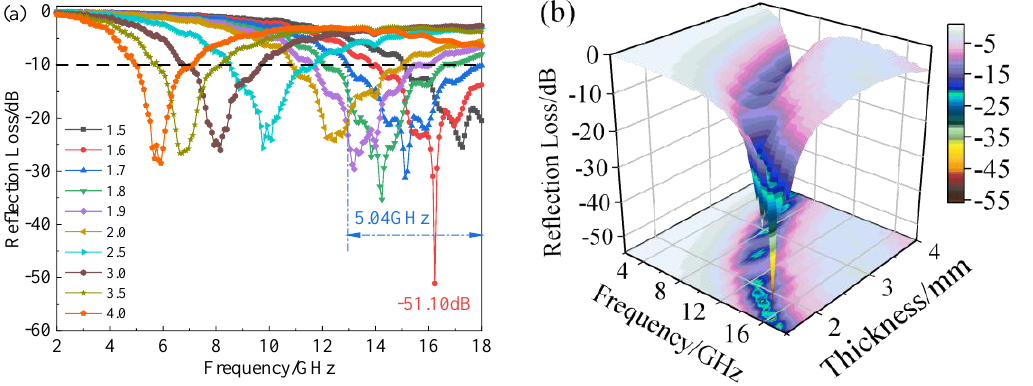
Figure 6. ( a ) RL diagram of the CB20-CIP30 composite with different thicknesses; ( b ) Three- dimensional diagrams of RL of the CB20-CIP30 composite with different thicknesses.